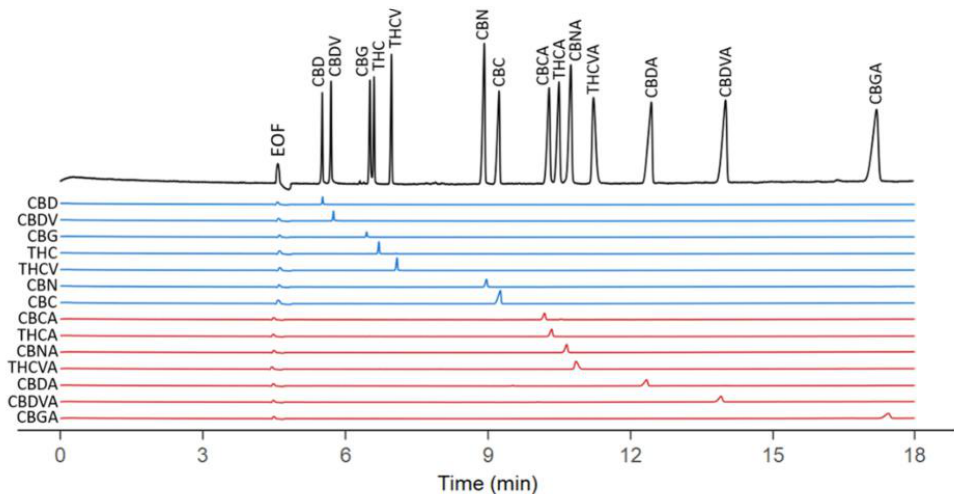
Figure 3 . CE electropherograms of 14 cannabinoids in a standard mixture and individually (electro- phoretic conditions: 6.5 mM sodium hydroxide in acetonitrile:water (60:40) mixture, 25 mM µM β